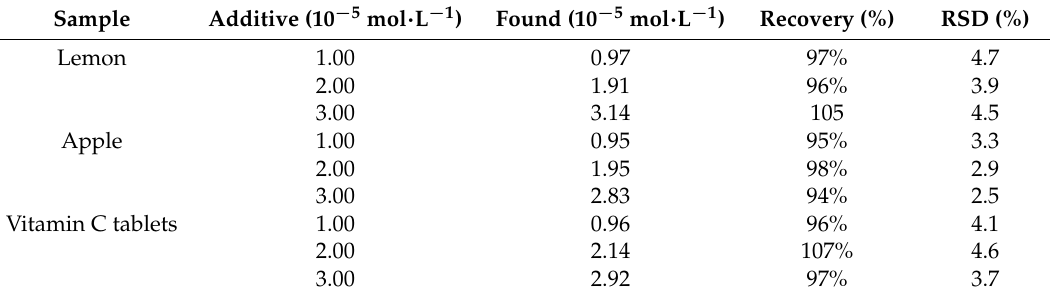
Table 3. Recovery studies for AA in samples (n =